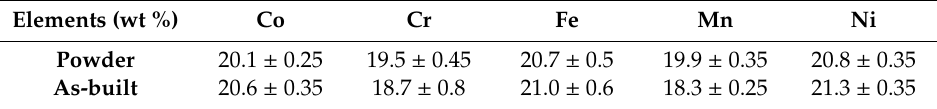
Figure 1. Powder morphology of CoCrFeMnNi alloy ( a ), particle size distribution ( b ) and schematic drawing of selective laser melting (SLM) scan strategy and printed sample orientation ( c ). Table 1. Chemical Compositions of alloy powder and as-built specimens.